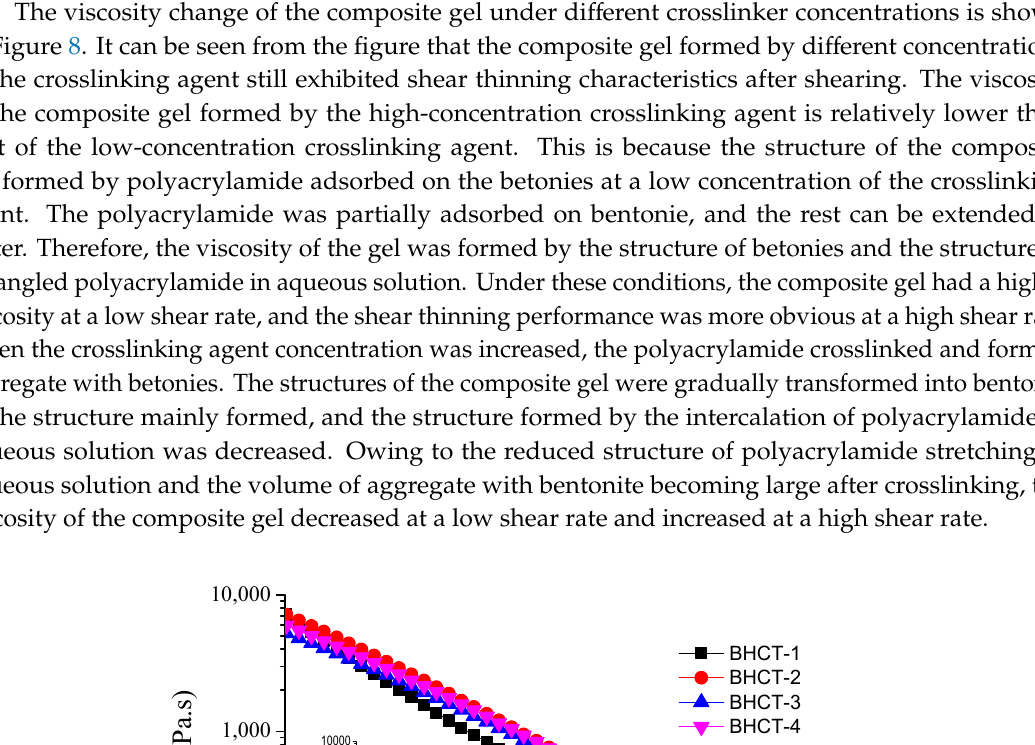
Figure 7. Internal structure changes under shear flow of composite gel.